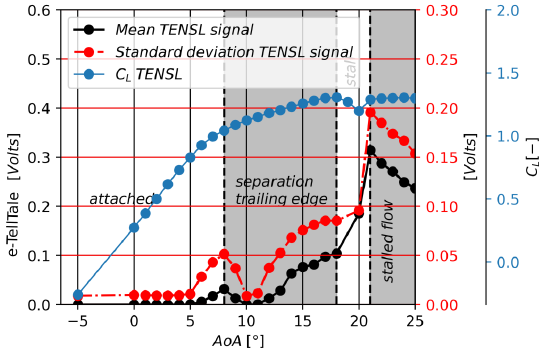
Figure 10. Mean and standard deviation of the e-TellTale TENSL signal and lift C L as a function of